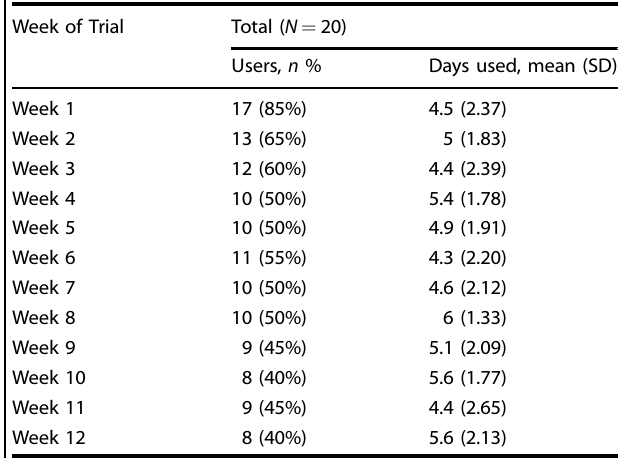
Table 4. App usage and mean days used for the MyCOPD arm in participants who did not withdraw from the study.